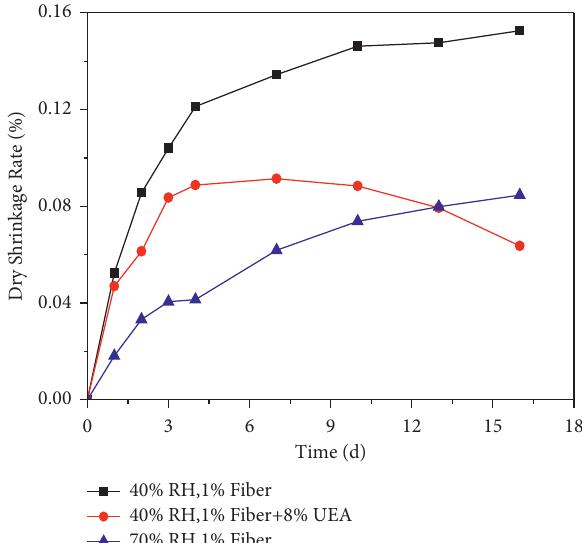
Figure 10: Effect of expansion agent content on drying shrinkage performance of GRC prepared under different humidity